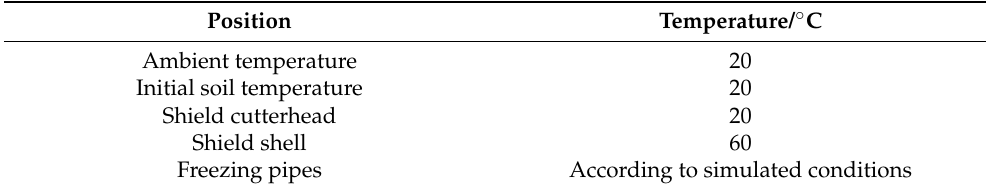
Table 2. The thermophysical parameters of materials. Frozen Soil Unfrozen Soil Air Thermal conductivity/(W/(m · K)) 1.79 1.18 0.023 Specific heat capacity/(J/(kg · K)) 1610 1530 1003 Density/(kg/m 3 ) 1880 1880